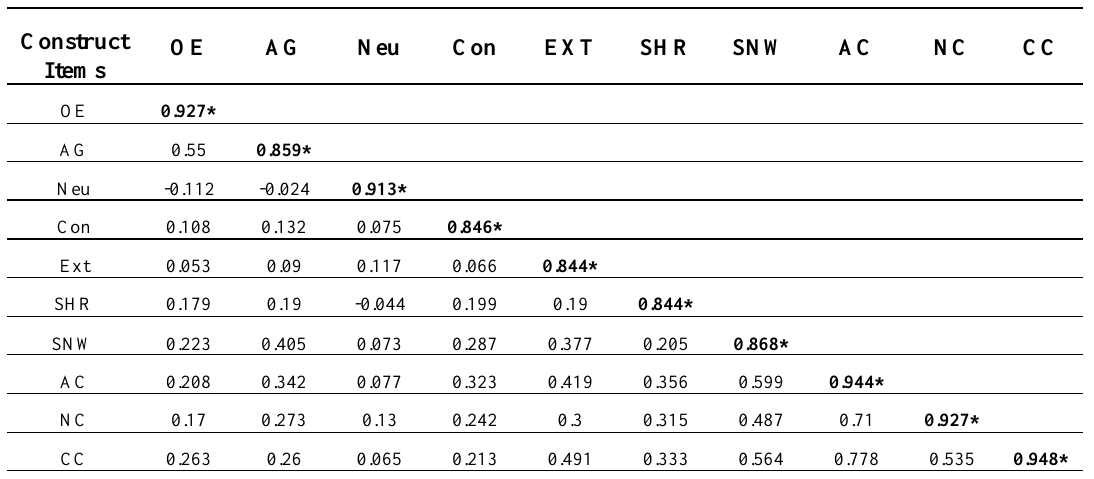
Table.2: Discriminant